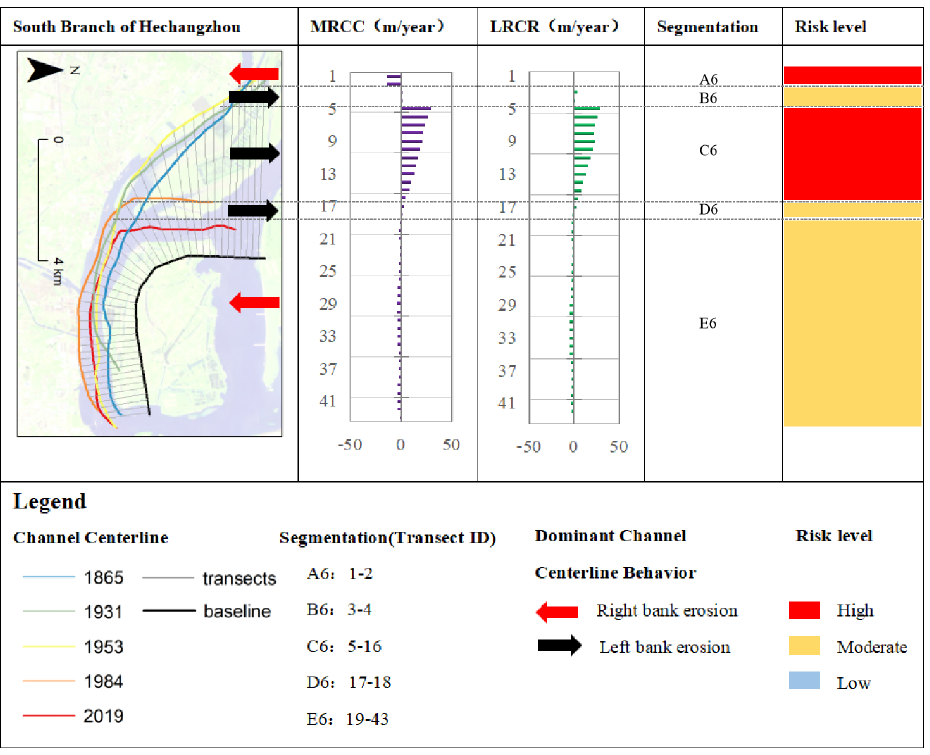
Figure 10. The Migration Rate of Channel Centerline, Linear Regression Change Rate, and erosion risk identification on South Branch of Hechangzhou. risk identification on South Branch of